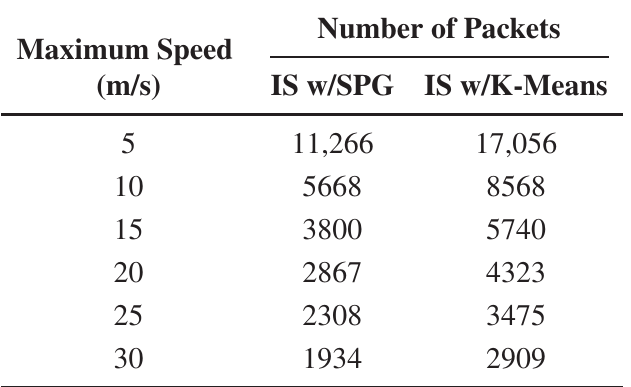
Table 4. Maximum number of packet in buffer of